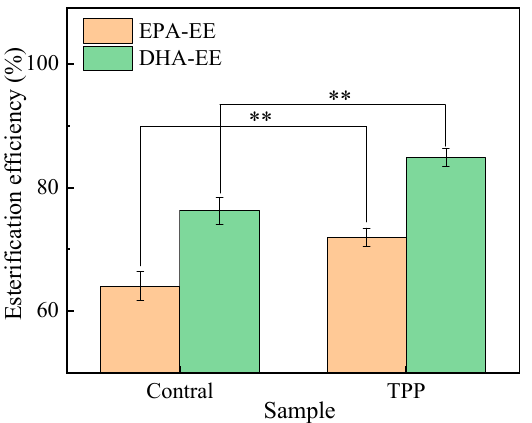
Figure 1. Effect of TPP added before or after the process of ethyl esterification on POV ( A ), TBARS ( B ), EPA-EE content ( C ) and DHA-EE content ( D ) of ethyl-esterified fish oils stored at 60 °C for different times. Values of different groups with different uppercase letters (A–D) or lowercase letters (a–d) are significantly different at p < 0.05; The asterisks (*) indicate the significant differences between the two groups with the same storage time at p < 0.05. The asterisks (**) indicate the significant differences between the two groups with the same storage time at p < 0.01.